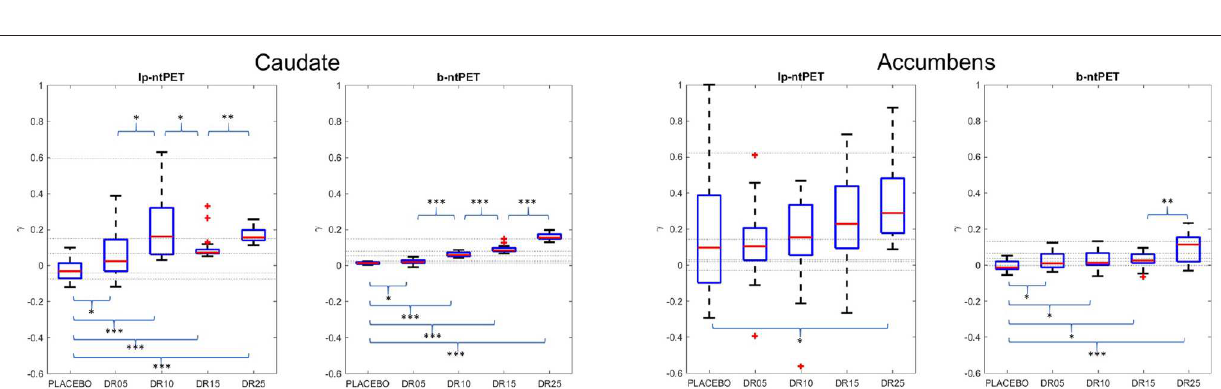
FIGURE 8 | Estimates of the magnitude parameter γ across conditions obtained with lp-ntPET and b-ntPET. Horizontal lines correspond to the reference values that are obtained by fitting the noiseless TACs with each method (lp-ntPET and b-ntPET). (Left) , caudate; (Right) , accumbens. Whiskers represent 1.5 times the IQR. (Paired t -test: * p < 0.05; ** p < 0.001; *** p <